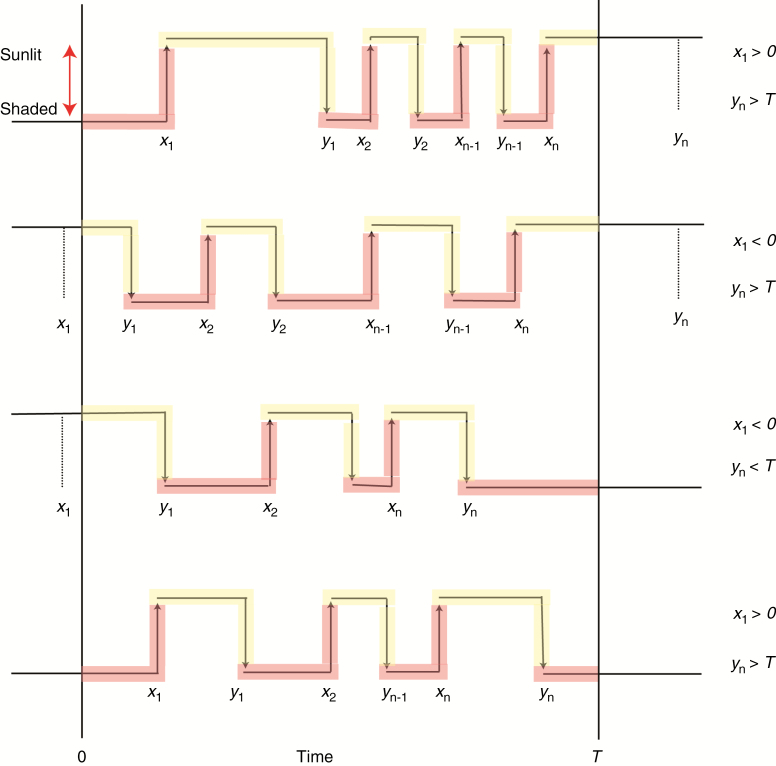
Illustration of the notation for the model, showing the four possible combinations of states at the beginning and end of the interval [0,T]. At time
t=0, a sunlit state is indicated by
x1<0 and a shaded state by
x1>0; at time
t=T a sunlit state is indicated by
yn>T and a shaded state by
yn<T. The different sections are coloured to indicate how they contribute to the (log) likelihood functions: red denotes a contribution to on-switching functions [eqns (7) and (9)] and yellow to off-switching function [eqns (8) and (10)].